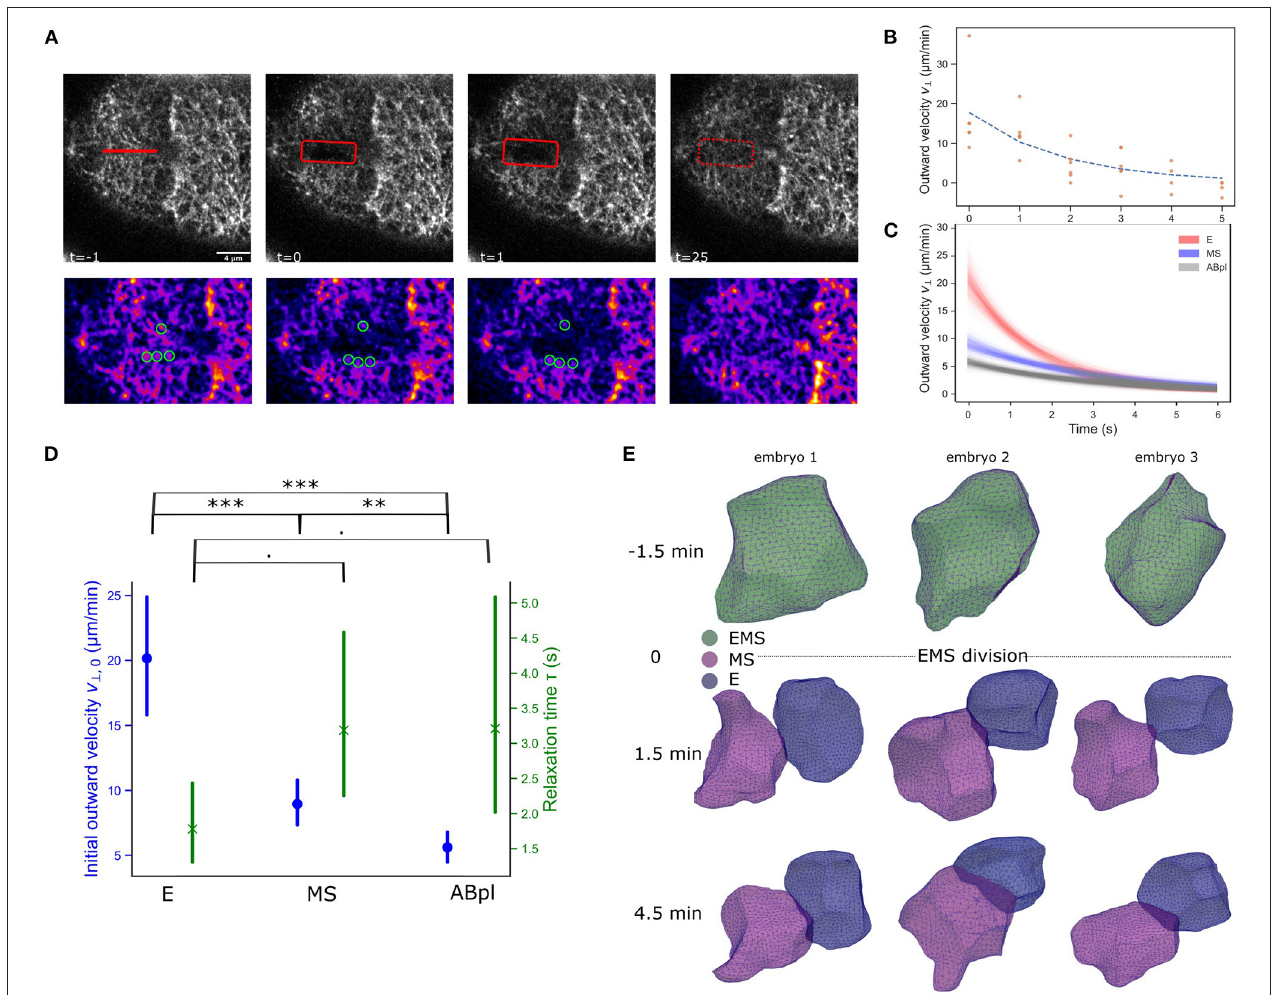
FIGURE 2 | The differences in the NMY-2 and F-actin markers across E and MS coincide with cortical tension differences and cell shape changes. (A) Illustration of cortical ablation experiments on an E cell. A 4 µ m cut is made by a pulsed 355 nm laser (UGA-42 Caliburn). In the sequence the opening of the cut, highlighted with the rectangle can be observed, followed by repair of the cortical disruption. The second row shows the manual PIV measurement for this experiment. The image is processed (blurring and background subtraction), and a color LUT is used to better see intensity contrasts. Cortical features are marked with green circles. A modest recoil is noted, and after ± 25 s the cut is repaired. Scale bar is 4 ν m. (B) Output of the PIV analysis. An example of outward velocities for an E cell are shown with an exponential trend fit. The movement is quickly reduced to low levels and the maximal gap opening is achieved after 3–5 s. (C) Exponential fit for the ablations of E, MS, and ABpl cells, with confidence interval. The analysis is based on 4, 7, and 7 experiments respectively. The E and MS cells show different initial velocities, which indicates E has larger initial tension than MS. For reference, also the ABpl cell was ablated, which has still higher F-actin/NMY-2 than MS (cf. Figure 1B ), and this cells shows very little cortical tension. (D) Statistical analysis of the cortical ablation experiment, showing both the initial outward velocity estimate and the relaxation time. Bars represent 95% confidence level and test results are based on a permutation test (weighted bootstrap, see section 2). · p < 0.1, ** p < 0.01, *** p < 0.001. (E) E and MS take different cellular shapes after division. Cells were reconstructed from images of embryos with membranes tagged by a membrane binding domain fused to